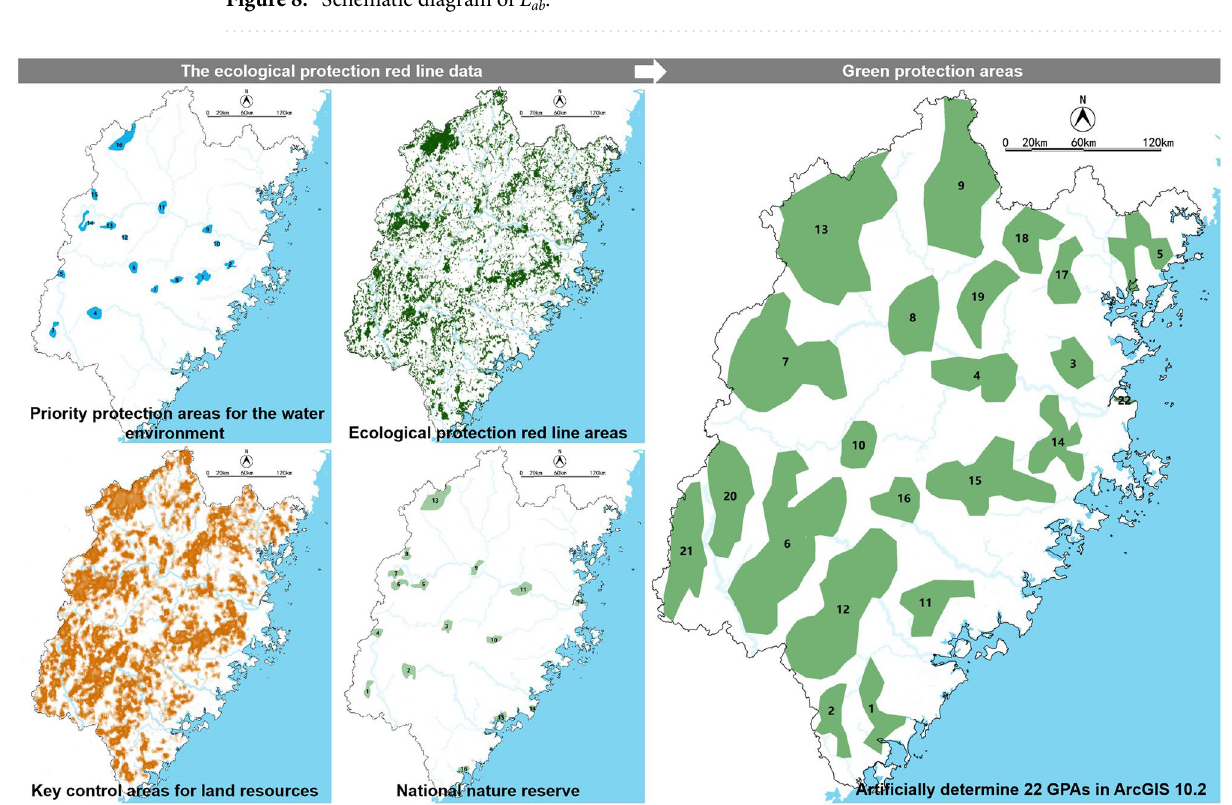
Figure 9. Process diagram of GPA determination in Fujian